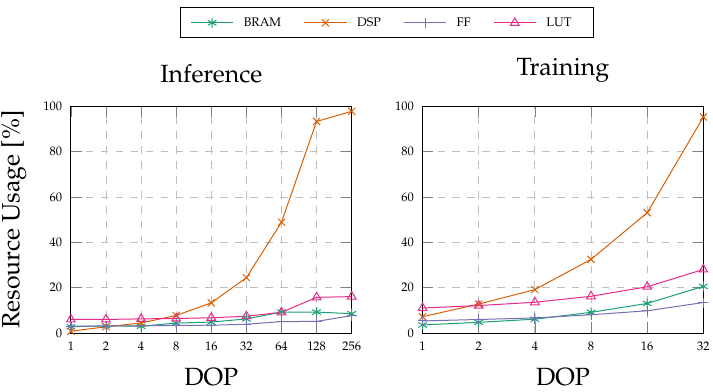
Figure 8. Resource utilization on